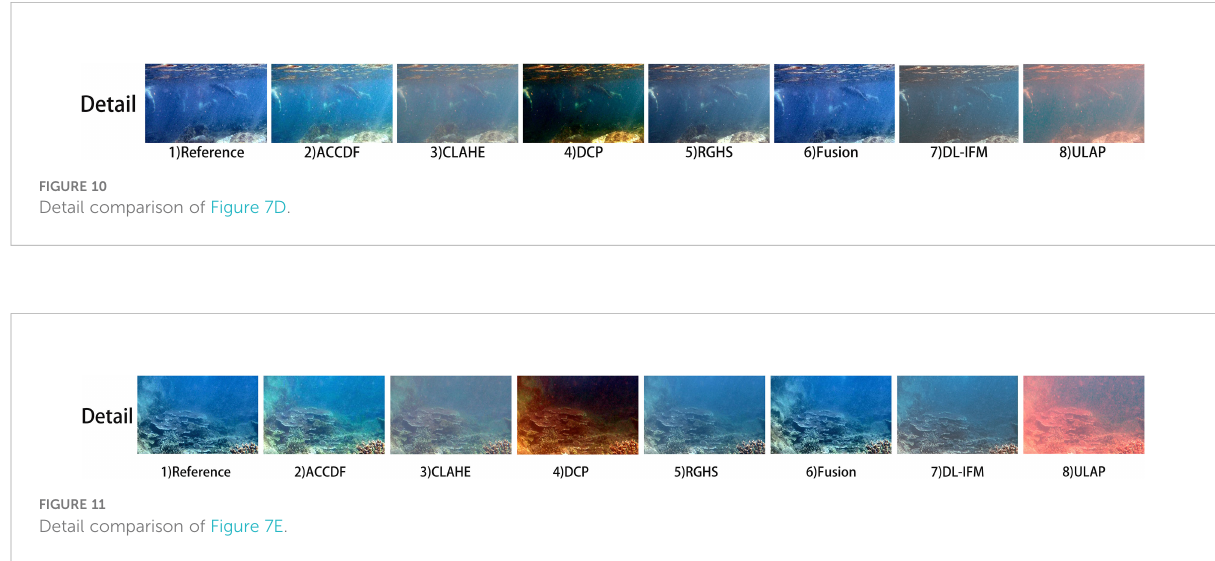
FIGURE 11 Detail comparison of Figure